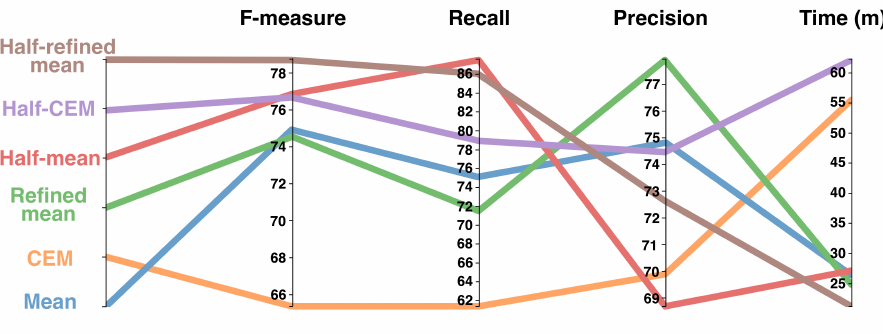
Figure 8. Effect of height estimation method on the performance.